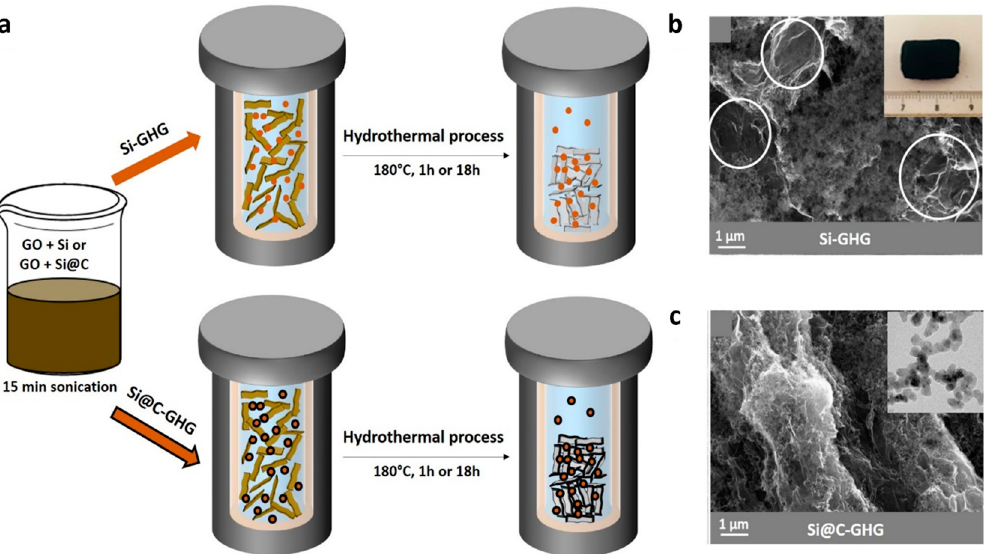
Figure 1. Scheme of the synthesis of Si-GHG (top) and Si@C-GHG (bottom) ( a ); SEM image of Si-GHG composite after 18 h synthesis; within inset a picture of the corresponding macroscale monolith; with white circles showing zones without Si NP ( b ); SEM image of Si@C-GHG composite after 18 h synthesis; within inset a TEM image of the pristine Si@C NPs used in the study ( c